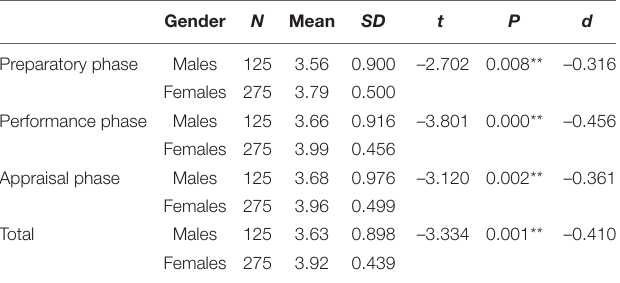
TABLE 1 | Gender differences for self-regulated online learning